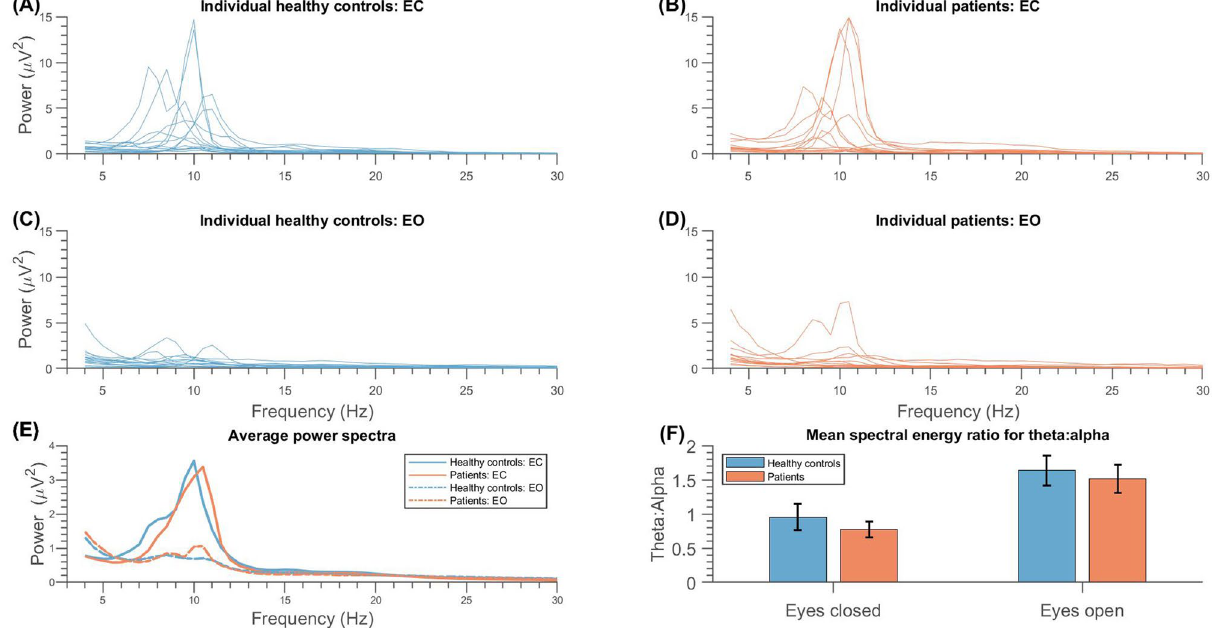
Figure 1. Spectral analysis of resting state activity for patients with chronic post-burn itch (orange) and healthy controls (blue). Spectra of mean power of global resting state activity recorded from all electrodes in ( a ) healthy controls (HCs) with eyes closed, ( b ) patients with eyes closed, ( c ) HCs with eyes open, and ( d ) patients with eyes open. Individual lines represent individual participants for plots ( a–d ). ( e ) Plot of mean power spectra for HCs (blue) and patients (orange), with full lines representing eyes closed (EC) and dashed lines representing eyes open (EO) conditions. Frequency bands of interests are distinguished left to right as white (theta: 4–7.5 Hz), grey (alpha: 8–12.5 Hz), and white (13–30 Hz) panels. ( f ) Mean spectral energy ratio for theta:alpha. With eyes closed, there is less theta compared to alpha power, whereas with eyes open there is more theta compared to alpha power, for both patients (orange) and HCs (blue). The theta:alpha between the patients (EC: Mean (M) = .77, standard deviation (SD) = .45, n = 14; EO: M = 1.51, SD = .74, n = 13) and the HCs (EC: M = .95, SD = .72, n = 14; EO: M = 1.64, SD = .82, n = 14) was not statistically significant for EC (t(26) = .81, p = .428) or EO (t(25) = .41, p =